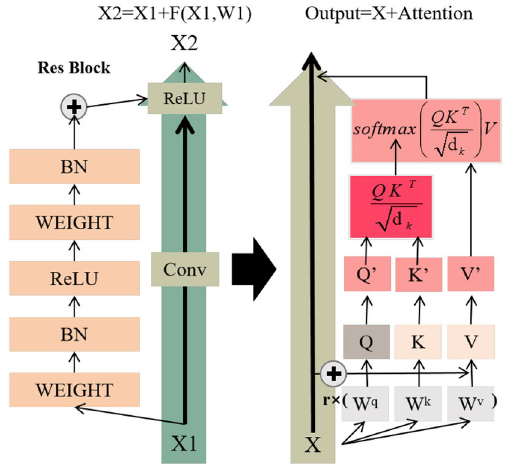
Figure 3. Layer-hopping connection